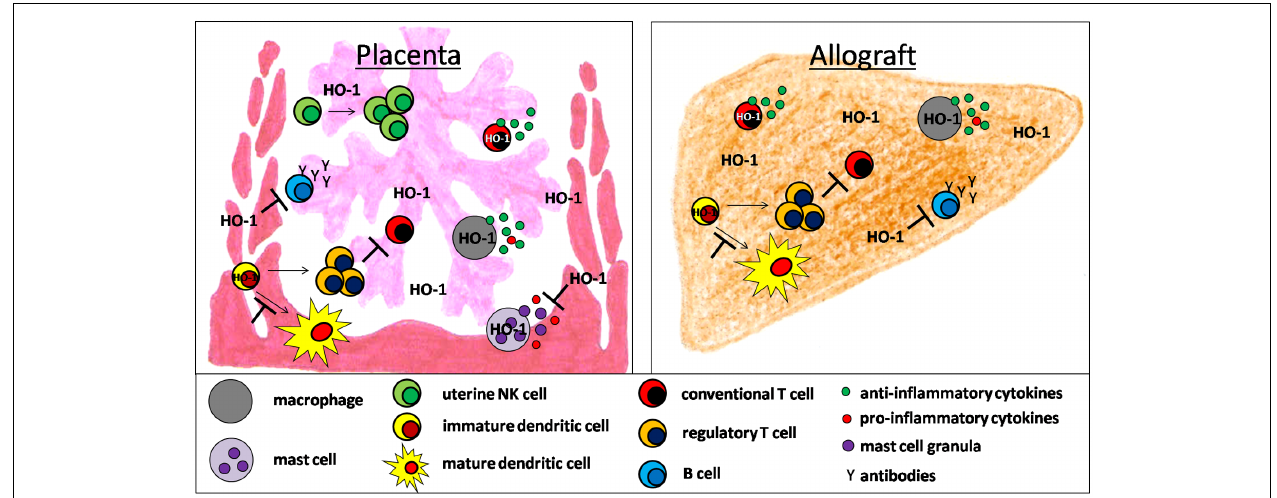
FIGURE 1 | Hypothetical scenario of HO-1-mediated effects on innate and adaptive immune cell populations supporting fetal and allotransplant tolerance.